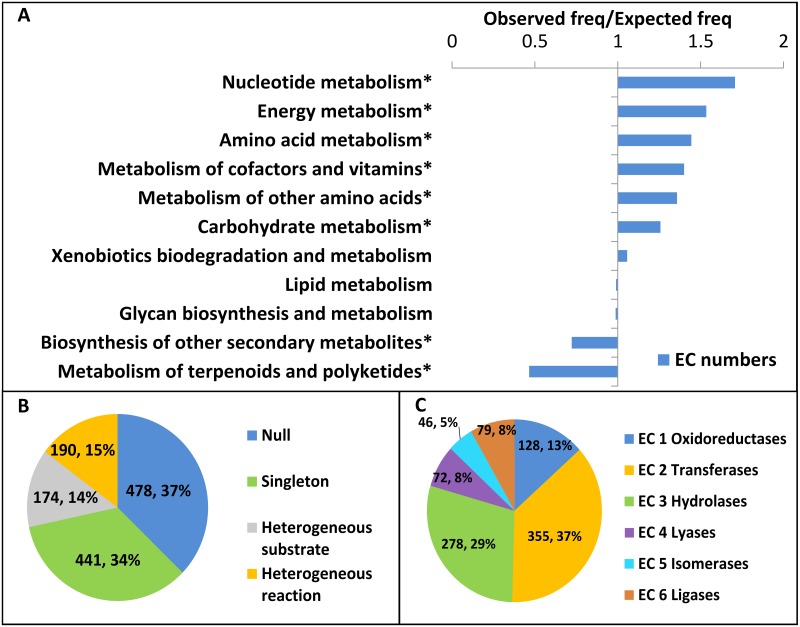
RLM enzymes reactions.(A) The ratio of observed and expected frequencies of metabolic reactions defines over (ratio>1) and under (ratio<1) represented pathway categories for RLM enzymes. Asterisks denote significant values according to Fisher’s exact test (P < 0.05). (B) Reaction categories of ECOD RLM families are depicted as a pie chart: families without any assigned EC reactions (Null), families with a single EC reaction type (Singleton), families with similar chemistries, but different substrates (Heterogeneous substrate), and families with different chemistries (Heterogeneous reaction) (C) Distribution of EC reaction classes among all RLM ECOD families that have an EC number assignment.